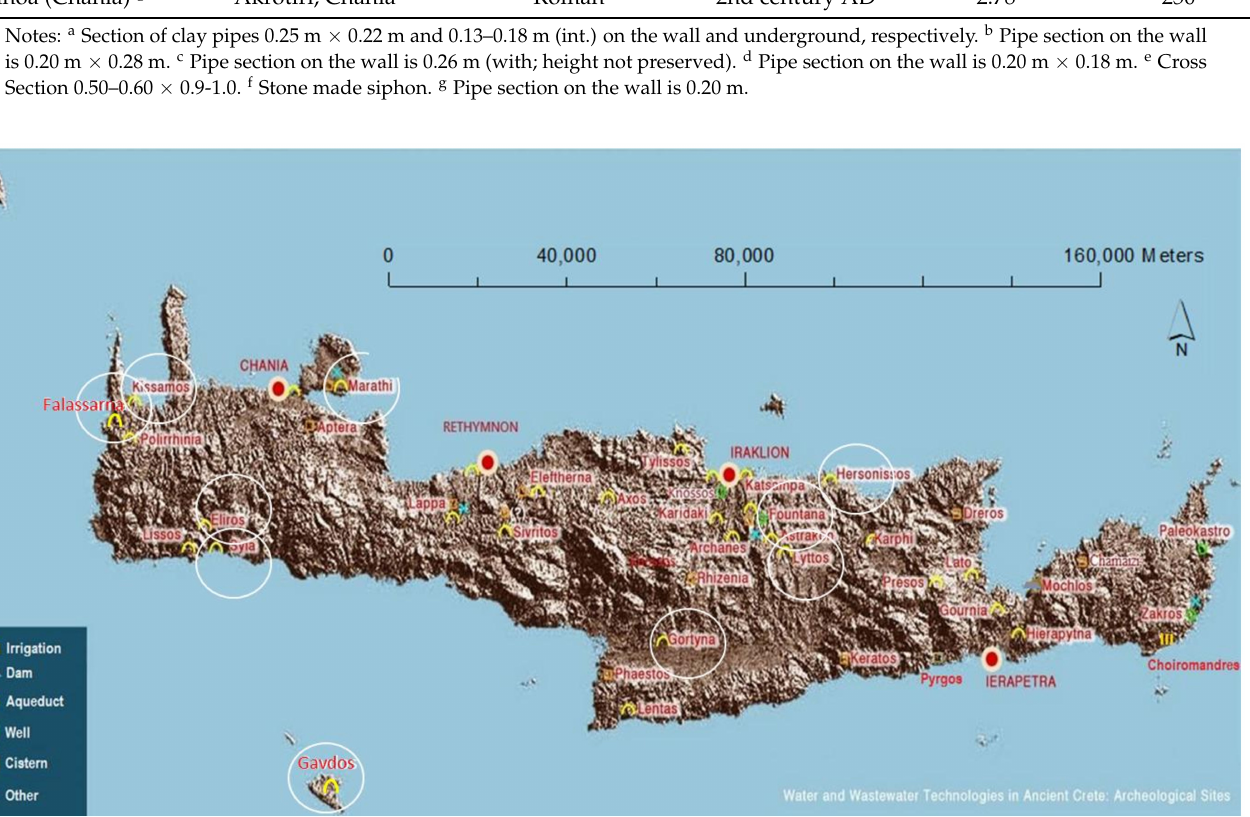
Figure 3. Geographical locations of the main aqueducts in the island of Crete, also including dams, wells, cisterns and irrigation channels. In circles are the locations of the aqueducts described in the study (provided by A.N. Angelakis). Roman aqueducts were usually constructed as buried masonry canals with a rect- angular inner profile and a semicircular vault (Figure 4). The larger channels were high enough to allow workers to cross. Structures like bridges (e.g., Gortys), inverted siphons (e.g., Lyttos) and tunnels (e.g., Fountana in Scalani) are standard applications in